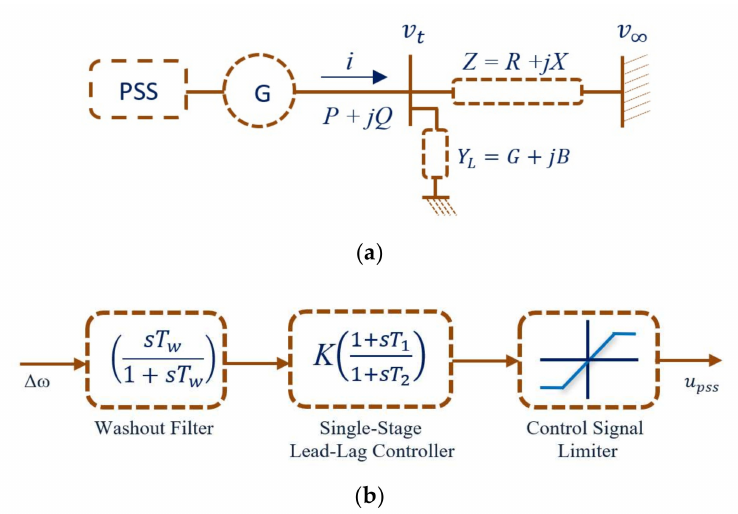
Figure 1. First test network; ( a ) single machine infinite bus (SMIB) system with power system stabilizer (PSS) only and ( b ) single-stage lead-lag PSS